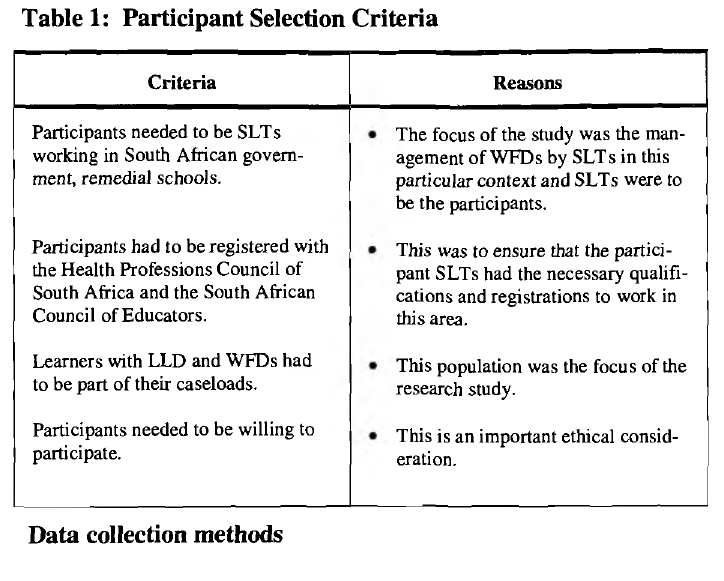
Table 1: Participant Selection Criteria